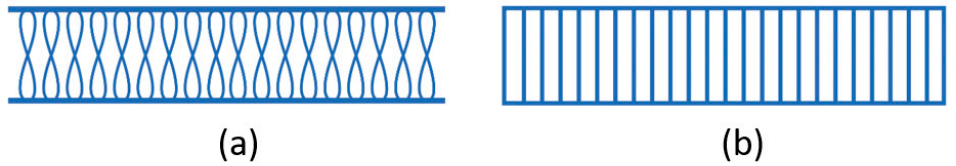
Figure 3. Schematic diagrams of ( a ) warp and ( b )weft direction samples. The bending experiment was conducted according to the standard GB/T 1449-2005 (test method for bending performance of fiber-reinforced plastics) [16]. The experiment was carried out under the conditions of one atmosphere pressure and a constant temperature of 25 ◦ C. The loading speed was 2 mm/min, and the span was set to 110 mm. After placing the composite material sample board horizontally, the loading head was kept still. The bracket holding the composite material sample board rose at a constant speed and gradually destroyed the composite material sample board. The time displacement, loading load, bending strength, elastic modulus, and bending strain data were generated automatically in the Bluehill 3 system. Figure 4a shows the equipment set up for the bending experiment, and Figure 4b shows the equipment set up for the flat compression experiment.